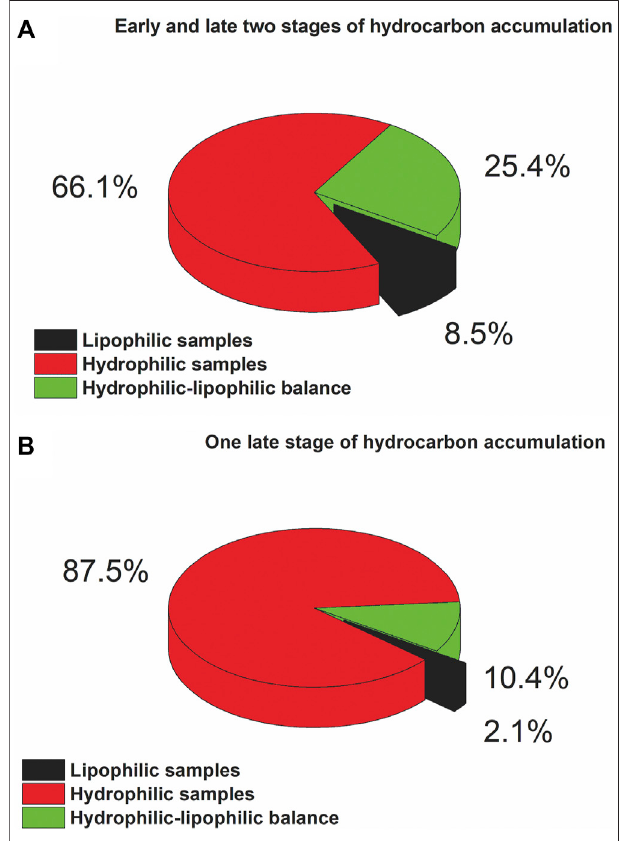
FIGURE 8 | Comparison of rock wettability between reservoir with the two hydrocarbon accumulation stages (A) and the reservoir with the one late stage (B) in the Dongying